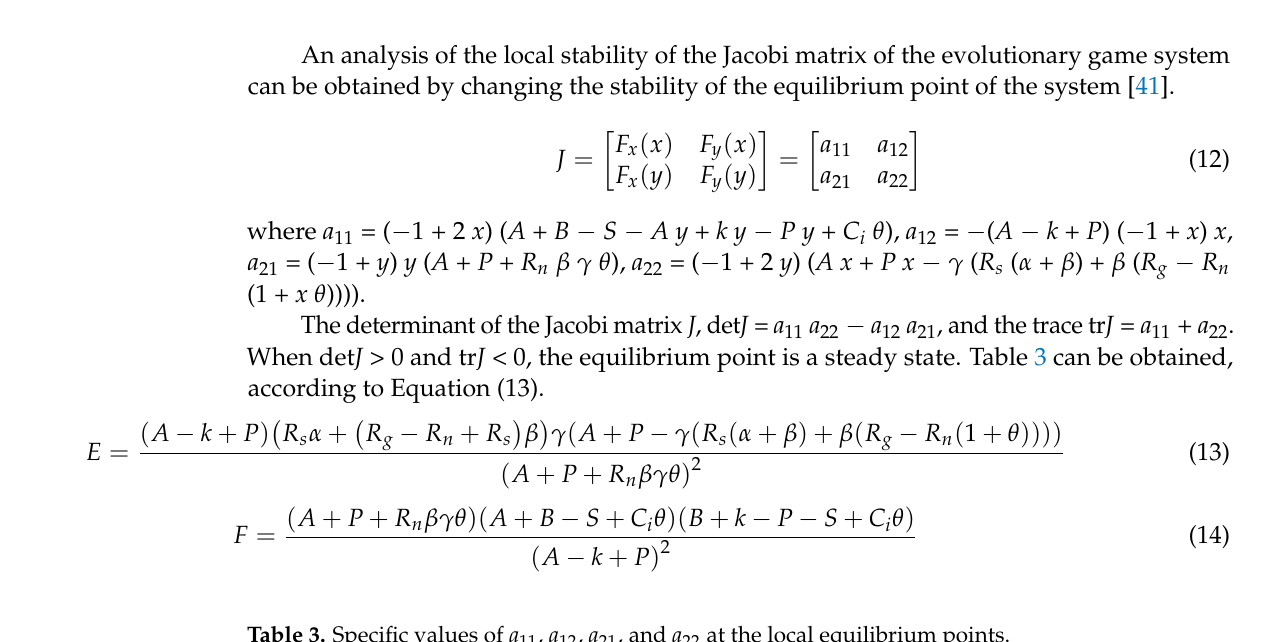
Table 3. Specific values of a 11 , a 12 , a 21 , and a 22 at the local equilibrium points.